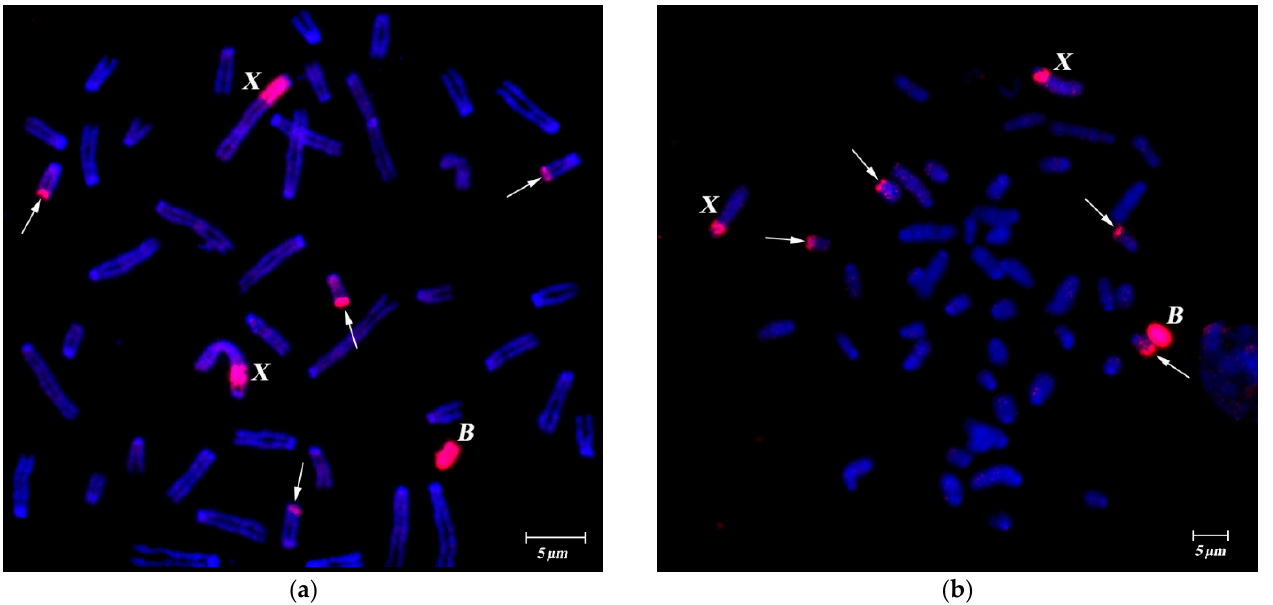
Figure 1. FISH of B-specific Whole Chromosome Paint (WCPB) (red signal) onto metaphases of females with one B chromosome from different populations of A. flavicollis . ( a ) WCP3977B probe (from a specimen from Petnica, Serbia) hybridized onto metaphase plate from fibroblast cell culture of female #3980 (Orašac, Serbia); ( b ) WCP3980B probe (from a specimen from Orašac, Serbia) onto a metaphase plate from bone marrow cells of female #26368 (Ulyanovsk region, Russia). Bs and X chromosomes are marked by corresponding letters; arrows indicate heterochromatic blocks on four small autosomes. DAPI total chromosome staining is blue. Scale bar 5 µm.